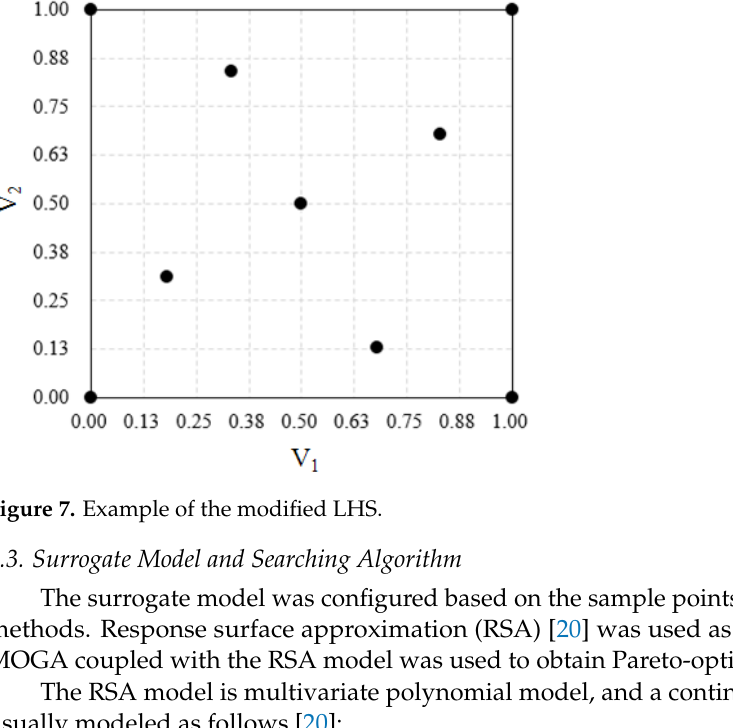
Figure 6. Example of conventional LHS.